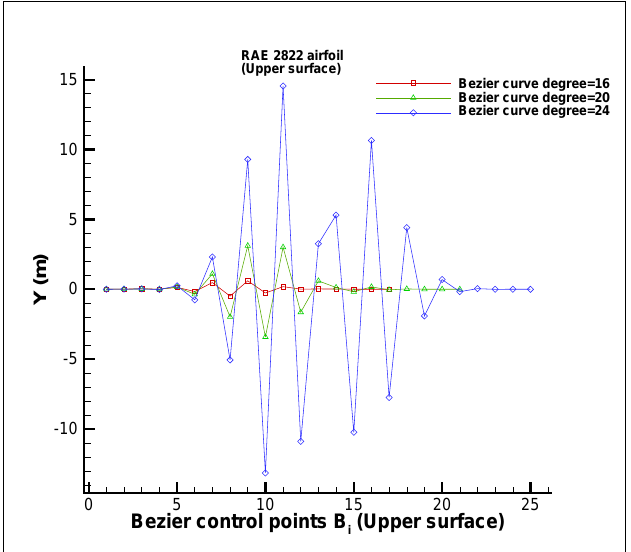
Figure 3. Comparison of the control points of Bezier curves of degrees 16 (17 control points), 20 (21 control points), and 24 (25 control points) for RAE 2822 airfoil.